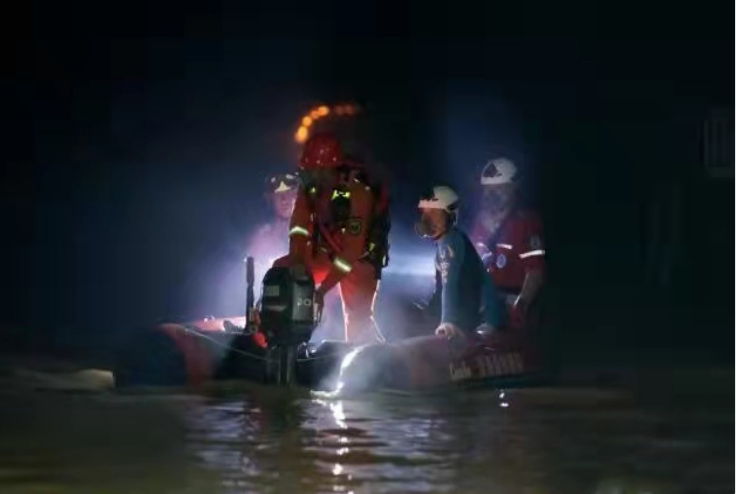
Figure 5. Rescuers are sending frogmen into the water. (Picture from: https://www.xianjichina.com/news/details_275025.html, accessed on 18 January 2022).